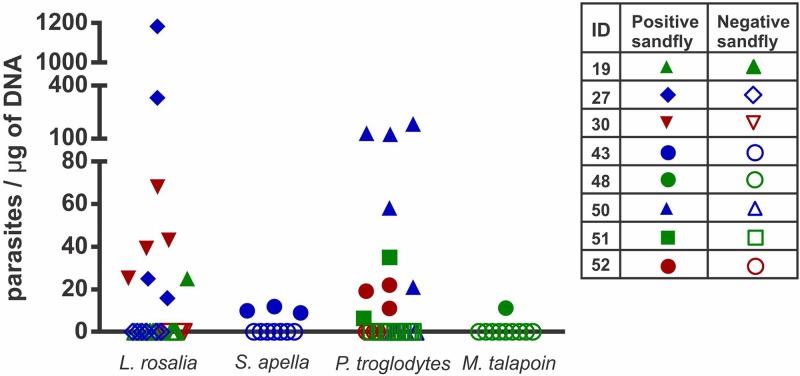
Quantitative analysis of Leishmania infantum in Lutzomyia longipalpis exposed to non-human primates.Relative quantification of L. infantum promastigotes in each individual positive sand fly according to the non-human primate species. Symbols refer to individual animals: open symbols indicate negative sand flies, and solid symbols indicate infected sand flies.